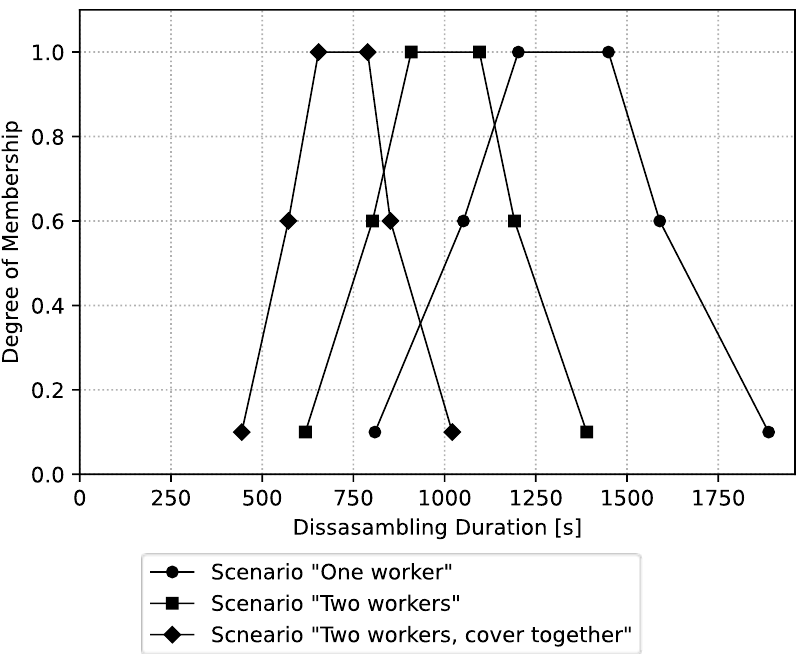
Figure 7. Membership function of fuzzy minimum disassembling completion time for different planning scenarios.